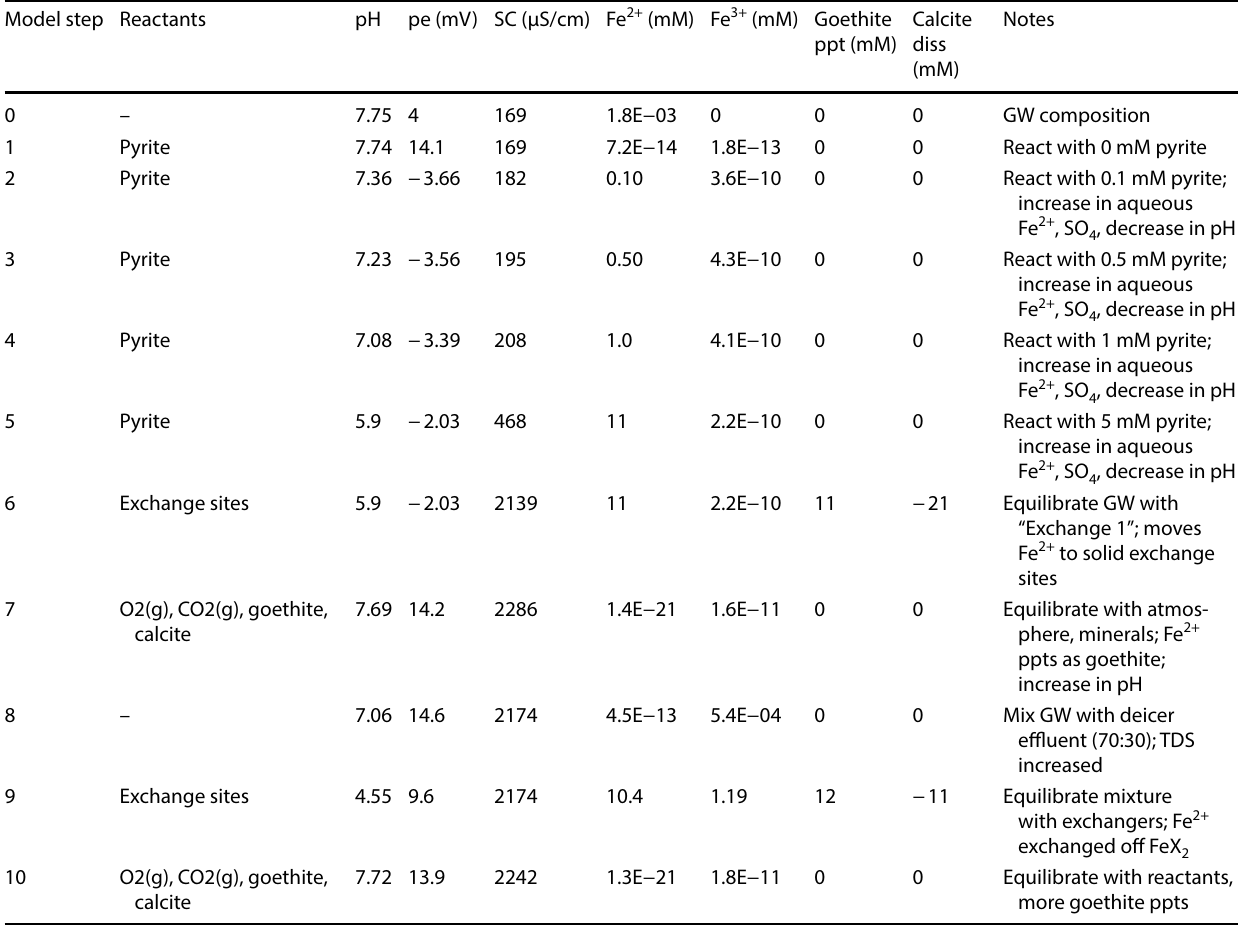
Table 5 Results of forward geochemical modeling using